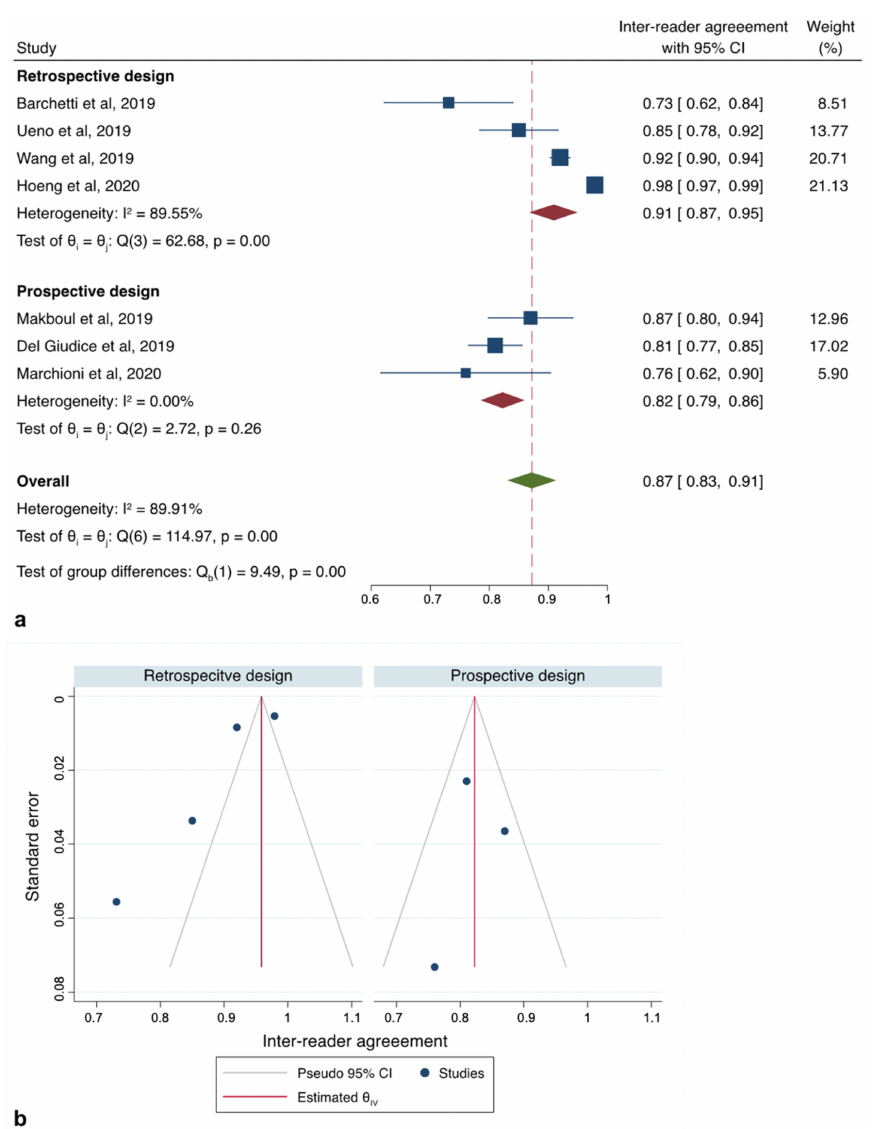
Figure 3. Sub-group analysis according to study design. ( a ) Forest plot reporting the pooled inter-reader agreement according subgroup analysis of the studies ( b ) Deeks’ funnel plot according to “study design”